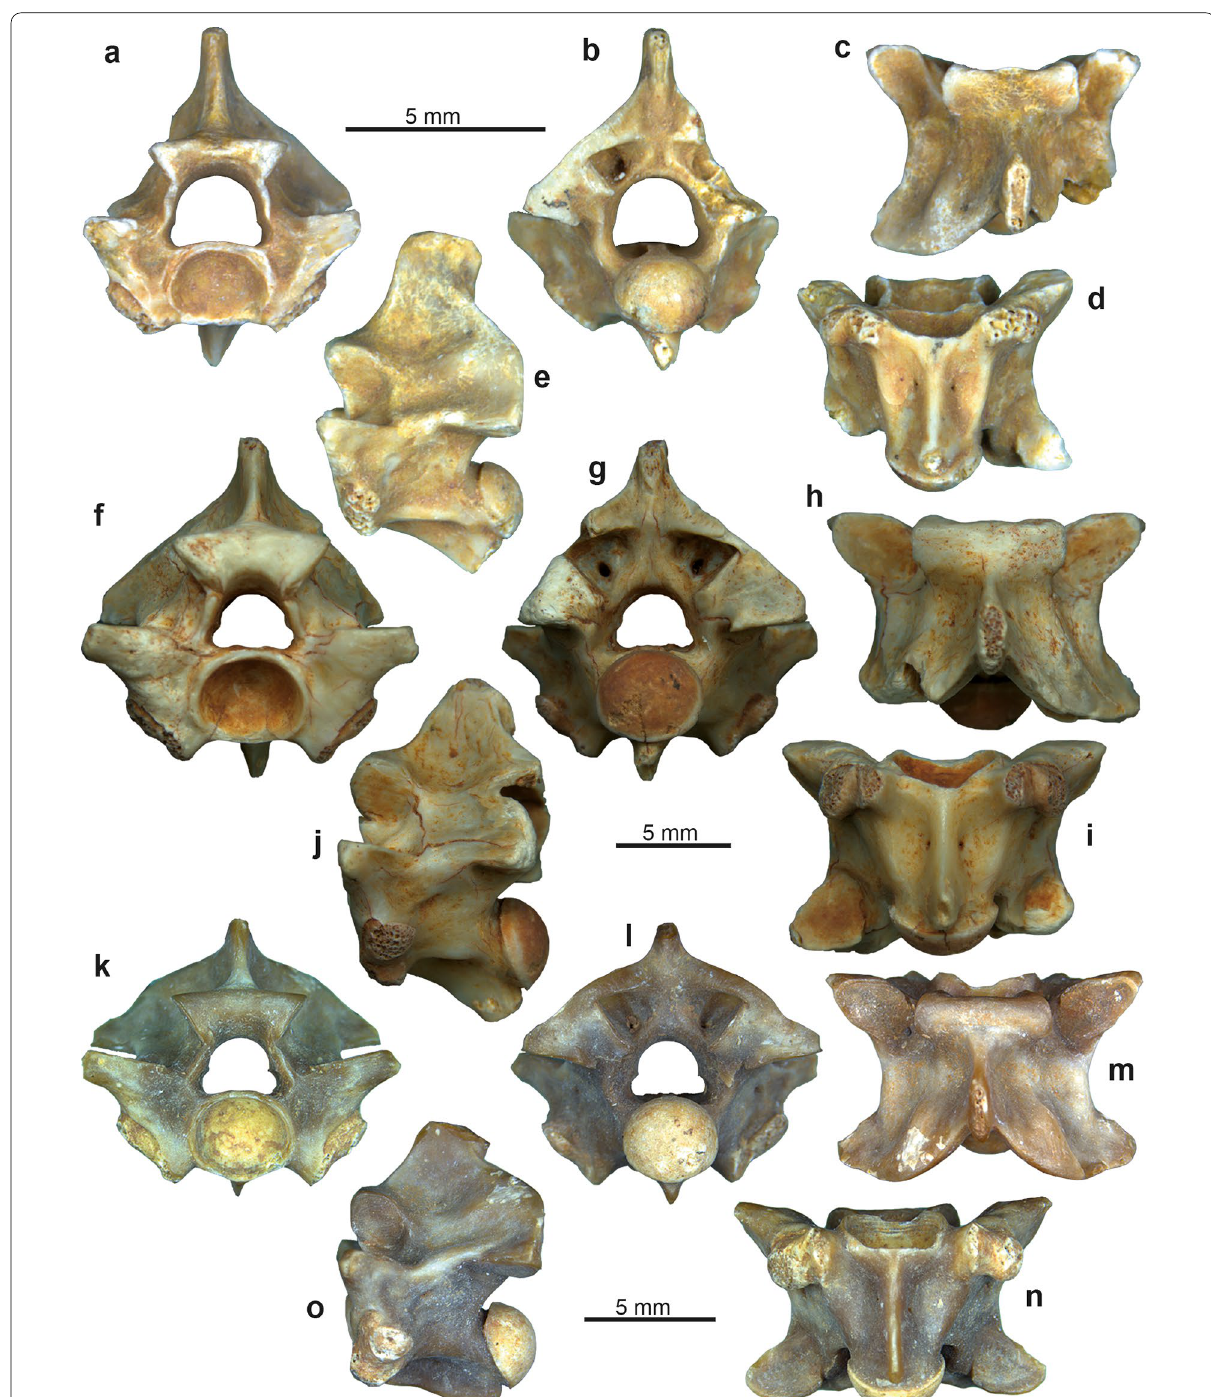
Fig. 83 Phosphoroboa filholii comb. nov. from imprecisely known locality(ies) near Mouillac, Phosphorites du Quercy: a – e anterior trunk vertebra (YPM-VPPU 30369) in anterior ( a ), posterior ( b ), dorsal ( c ), ventral ( d ), and left lateral ( e ) views; f – j anterior trunk vertebra (YPM-VPPU 30371) in anterior ( f ), posterior ( g ), dorsal ( h ), ventral ( i ), and left lateral ( j ) views; k – o mid-trunk vertebra (YPM-VPPU 30380) in anterior ( k ), posterior ( l ), dorsal ( m ), ventral ( n ), and left lateral ( o )